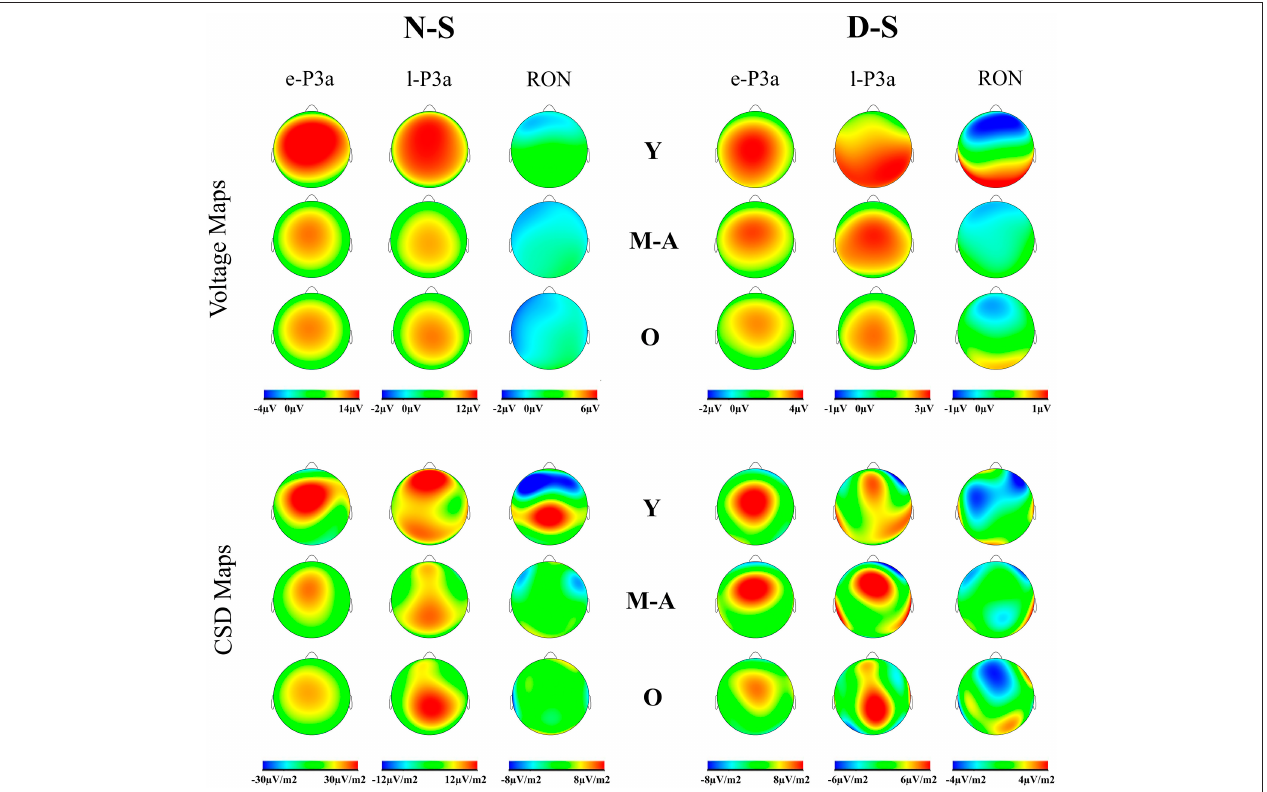
FIGURE 4 | Voltage maps and current source density (CSD) for e-P3a, l-P3a, and RON maximum peaks, in the novel minus standard (N-S) and deviant minus standard (D-S) difference waveforms, for the three age groups (Y, young; M-A, middle-aged; O,